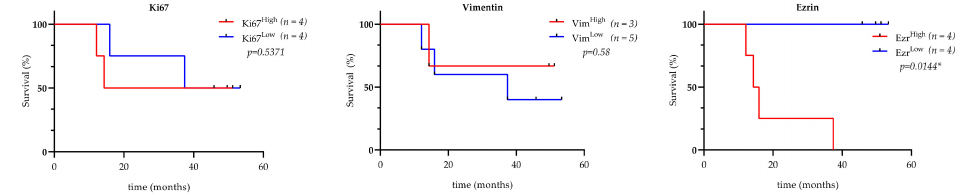
Figure 8. Overall survival curve (Kaplan–Meier) in relation to Ki67, vimentin, and ezrin median immunoexpression. Survival fraction (expressed in %) throughout the follow-up time is shown, related to every patient whose tumors formed PDXs (high and low expressions were obtained using the median H-scores of every corresponding protein as a